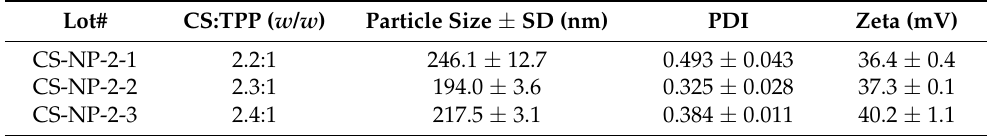
Figure 1. ( A ) The appearances of the chitosan nanoparticles (CS-NPs) in different conditions (Inad- equately/Adequately/Excessively Cross-linked); ( B ) effect of tripolyphosphate (TPP) and CS doses on the form (Aggregates/Nanoparticles) of products; ( C ) effect of TPP and CS doses on particle size of CS-NPs; ( D ) effect of TPP and CS doses on PDI of CS-NPs. (CS solution was kept at 5 mL with pH 4.0; the volume ratio of CS solution: TPP solution was kept at 5:2 for all the preparation experiments. TPP solution was slowly added into CS solution under magnetic stirring (15,000 rpm, 30 min) at room temperature). Table 1. Dynamic light scattering (DLS) detection of CS-NPs prepared by using different CS/TPP mass ratios.